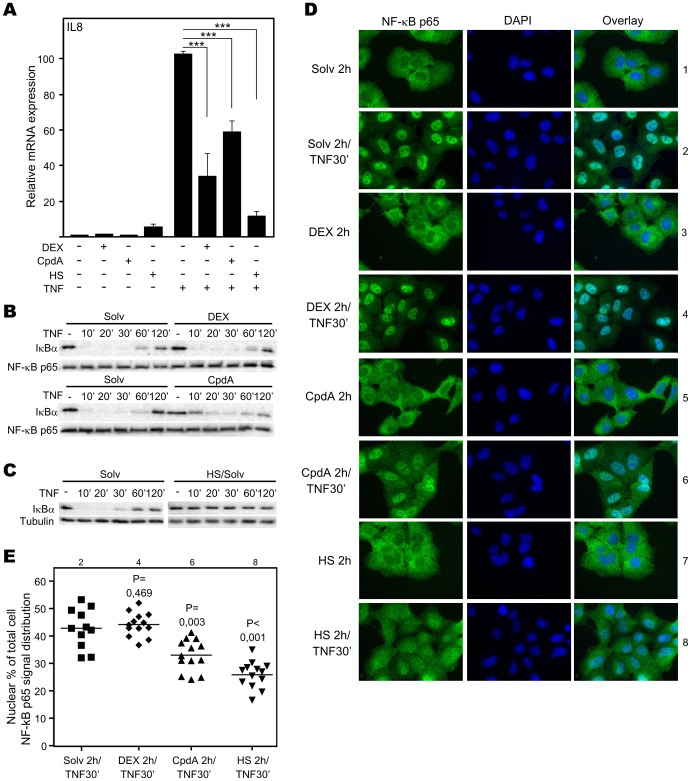
Both Compound A and heat shock diminish NF-κB-driven gene expression and NF-κB activation.(A) A549 cells, starved for 48h, were pretreated for 1.5h with solvent (Solv), DEX (1µM), CpdA (10µM) or subjected to heat shock treatment (1h at 43°C and 30′ recovery at 37°C), ensued with TNF (2000IU/ml) for 5.5h. Isolated total RNA was subjected to RT-qPCR assaying IL8 mRNA levels, normalized to cyclophilin household gene mRNA levels. The TNF condition was set at 100 and results were recalculated accordingly. These results are representative of 2 independent experiments. Statistical analysis (ANOVA and Tukey multiple comparison post test) were performed for selected pair-wise comparisons. (B) A549 cells, starved for 48h, were pretreated for 2h with solvent (Solv), DEX (1µM) or CpdA (10µM), after which TNF(2000IU/ml) was added as indicated. Western blot analysis of total cells lysates detects IκBα protein, with NF-κB p65 as loading control. This figure is representative for 2 independent experiments. (C) A549 cells, starved for 48h, were untreated or heat-shocked at 43°C for 2h. Ensuing, cells were treated by TNF (2000IU/ml) for the indicated times. Total cell lysates were analyzed as in (B), with tubulin as loading control. Results were obtained on 2 separate blots in one experiment. (D) A549 cells, starved for 48h in Optimem, were pretreated for 2h with Solv, DEX (1µM), CpdA (10µM) or 2h heat shock (HS) at 43°C. Subsequently, TNF (2000IU/ml) was added for 30′, where indicated. After washing, fixation, and permeabilization, indirect immunofluorescence detects endogenous NF-κB p65. DAPI staining indicates the nuclei. Additionally, we present overlays. This figure is representative for 2 independent experiments. (E) ImageJ integrated density analysis of the TNF-treated conditions in (D) allows statistical analysis (Mann-Whitney U test) and we show the P-value of comparisons to the Solv/TNF condition. These results are representative of 2 independent experiments.